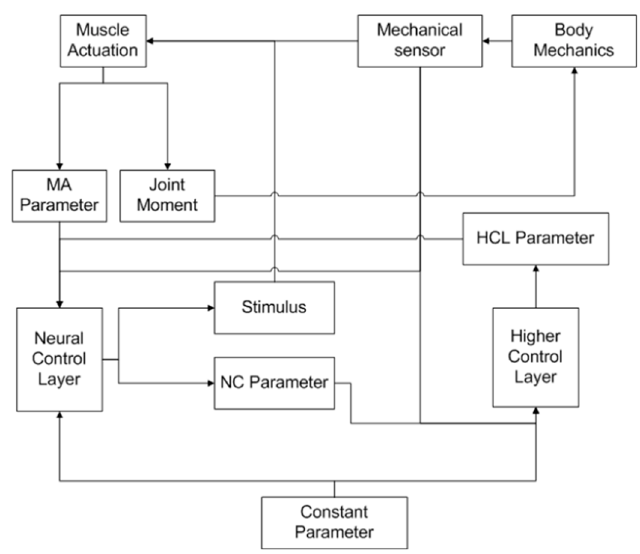
Figure 12. Neuromuscular control strategy framework [88]. There are four main parts: muscle actuation, body mechanics, neural control and higher control layers.